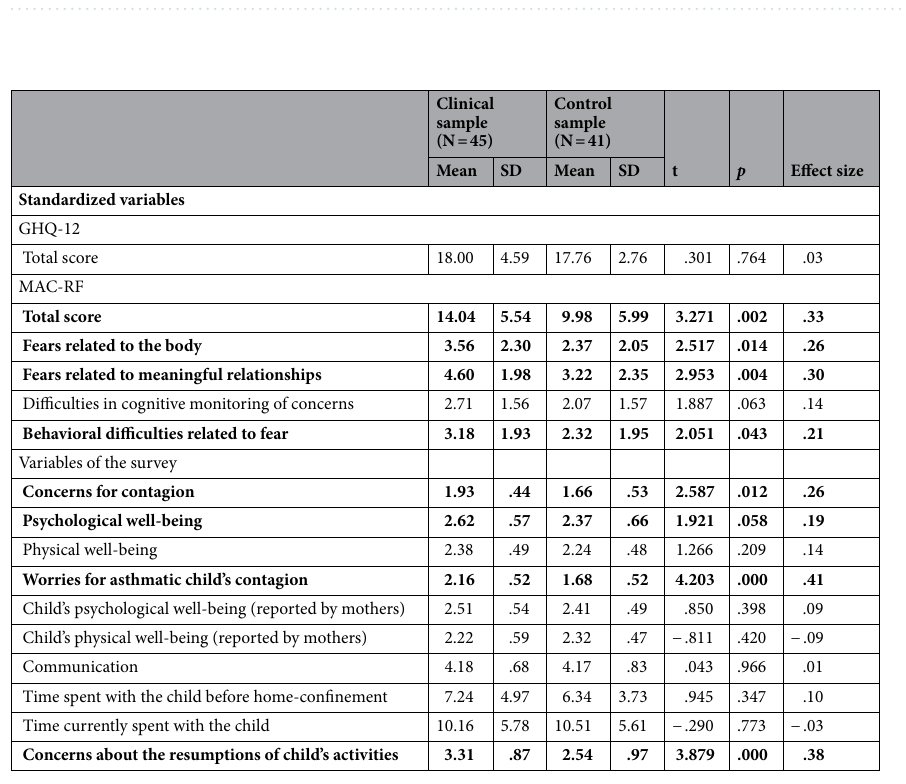
Table 3. Differences between clinical and control mothers’ samples’ scores in standardized questionnaires and in some selected variables of the ad hoc survey, calculated using student’s T-test. Standard deviations are reported. Bold for p -values<.05. *Note: effect size’s r values: .00–.20 low, .30–.50 medium, .60–2.00